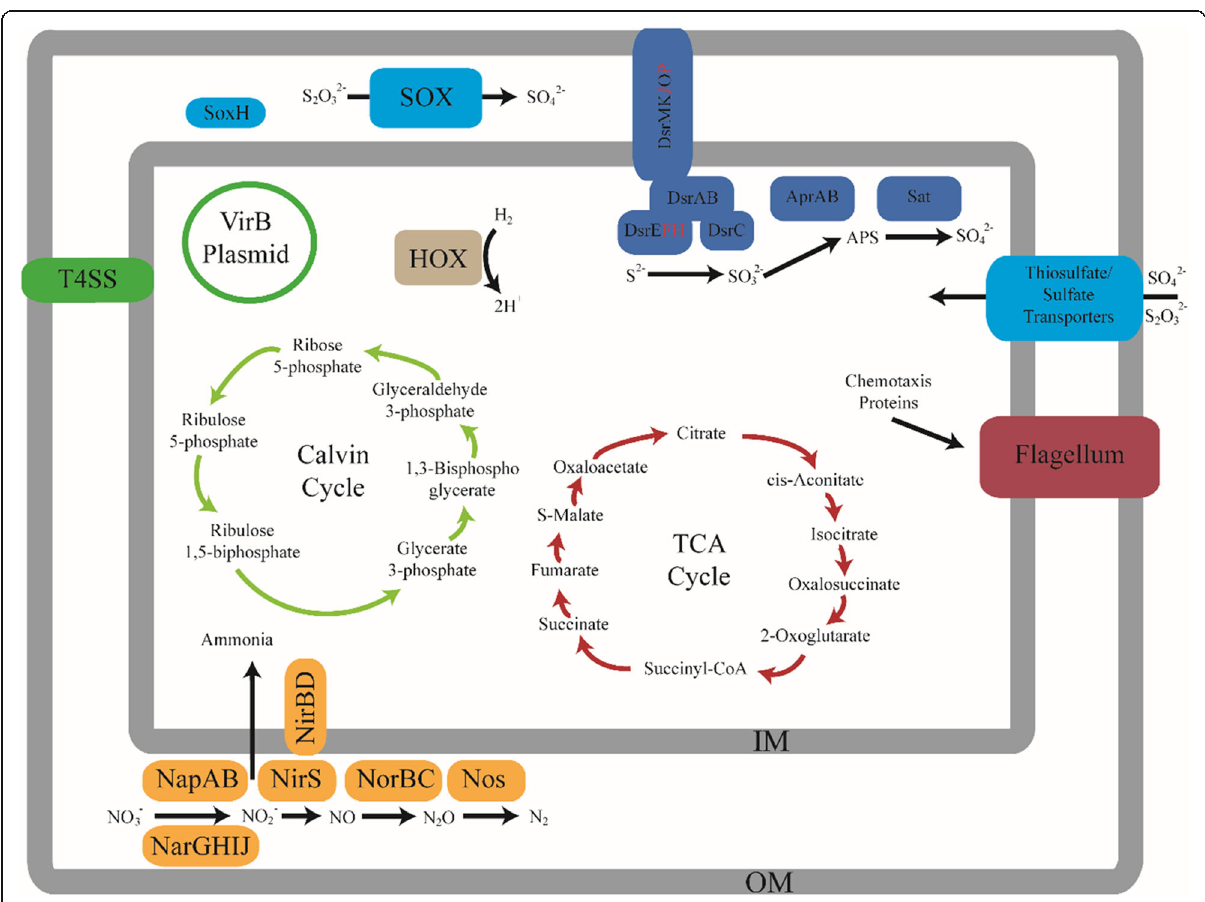
Fig. 1 Schematic representation of inferred metabolic capabilities of the Thyasira cf. gouldi symbiont. The major metabolic cycles discussed in this paper are highlighted within the figure. The inner membrane is designated by IM and the outer membrane by OM. Genes that were not identified within either annotation pipeline are designated by a red